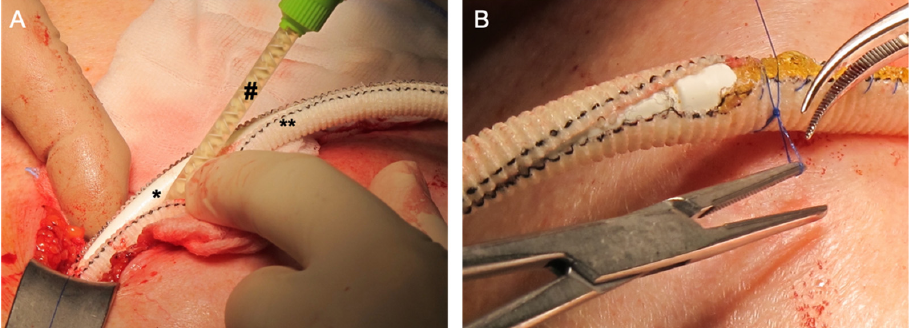
Figure 2. Intraoperative setup: ( A) the viscous bacteriophage-rich galenic (#) was applied between the driveline (*) and the Gore ® Synecore (**). ( B) The Gore ® Synecore was secured with sutures around the driveline before closing the wound.